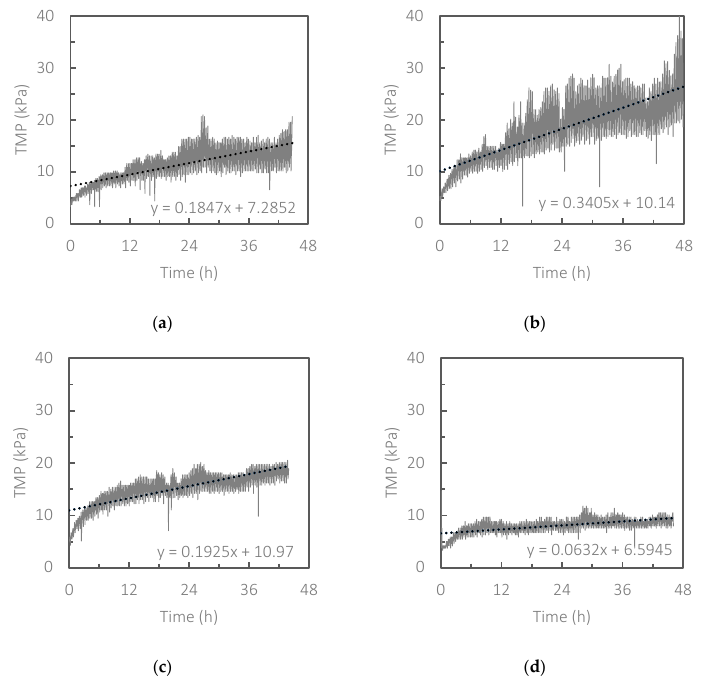
Figure 2. TMP evolution in Runs ( a ) 1.1, ( b ) 1.2, ( c ) 1.3 and ( d ) 1.4, in which the concentrations of NaClO in the backwash solution were set at 1000 ppm, 500 ppm, 100 ppm and 50 ppm, respectively. In these runs, granular scouring was also carried out.